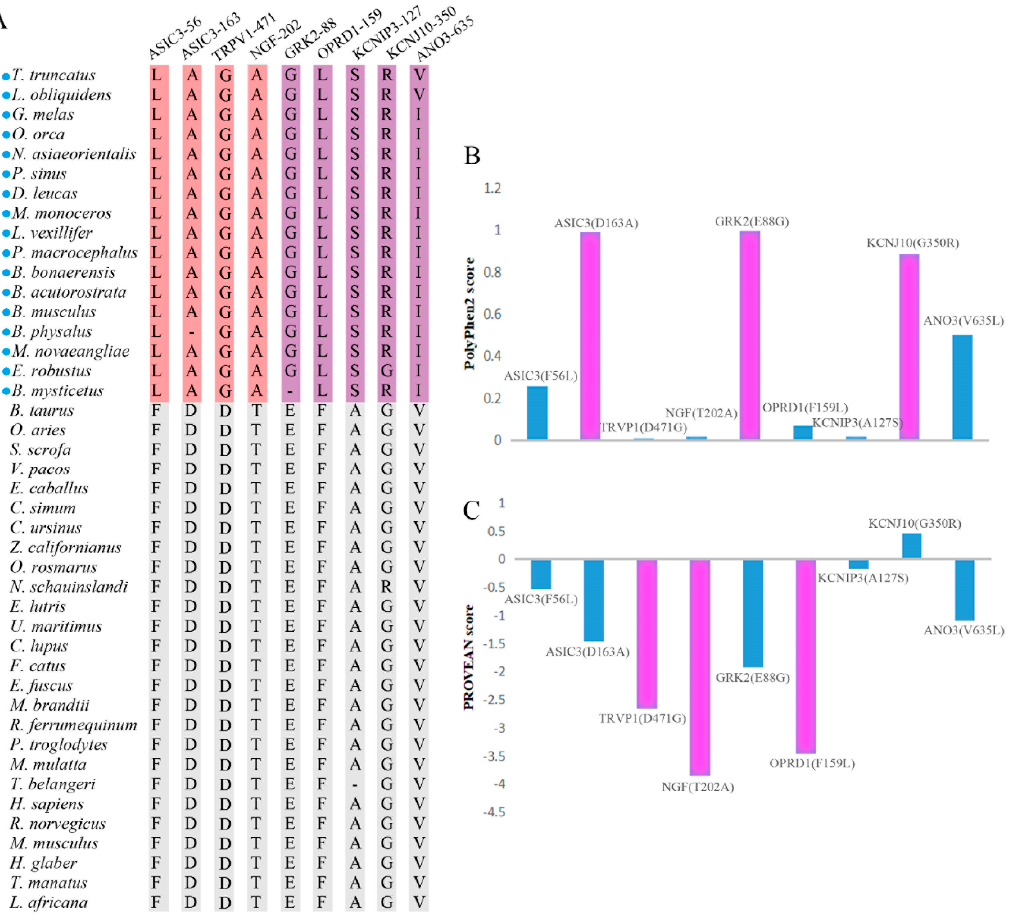
Figure 5. Cetaceans-specific amino acid substitutions. ( A ) Cetacean-specific amino acid substitutions identified in pain-related genes. Blue circles represent cetacean species. Amino acids in pink and purple are cetacean-specific amino acid substitutions identified in pain perception and analgesic genes, respectively. Amino acid positions are at the human scale. ( B ) Bar graph of the score of Polyphen2 predicting the effect of cetacean-specific amino acids on protein function. The purplish red bar graph shows that the scores are more than the threshold of 0.85, meaning that the protein’s function may be affected. ( C ) Bar graph of the PROVEAN score predicting the effect of cetacean- specific amino acids on protein function. The purplish red bar graph shows that the scores are less than the threshold of − 2.5, meaning that the protein’s function may be affected.